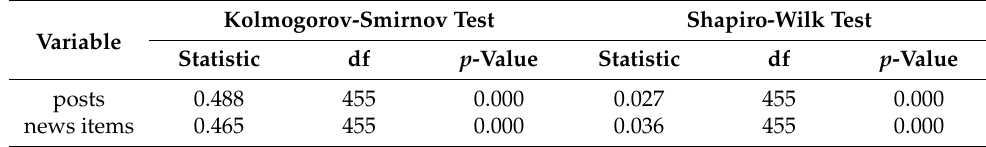
Table 4. Kolmogorov–Smirnov and Shapiro–Wilk test (posts and news items). Variable